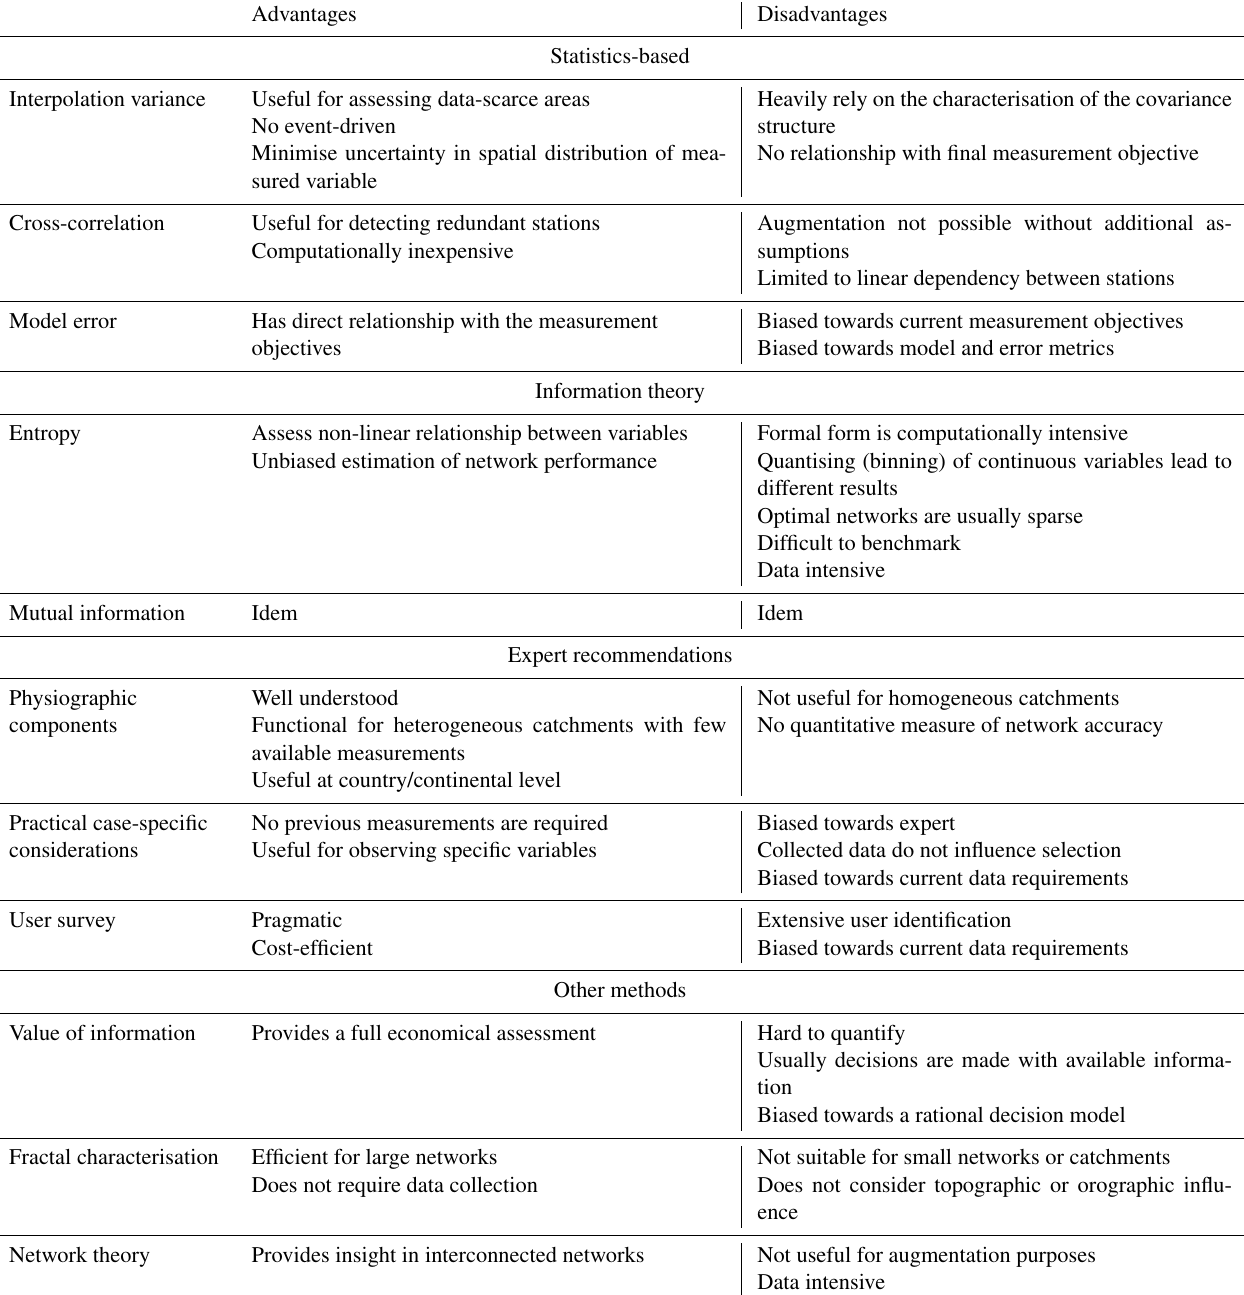
Table 3. Advantages and disadvantages of sensor network design